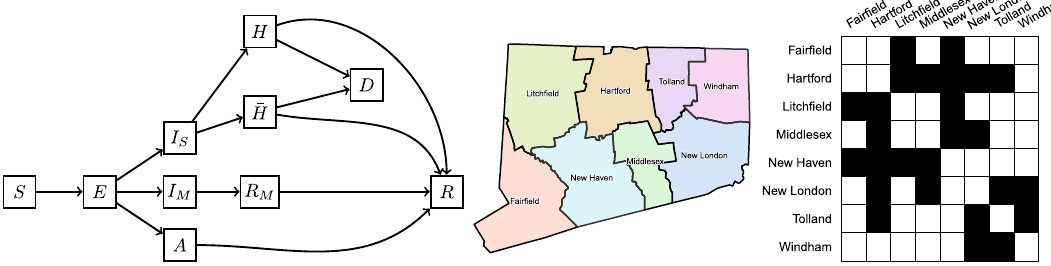
Figure 2. Schematic illustration of the model of SARS-CoV-2 transmission and COVID-19 disease progression; county map of Connecticut and county adjacency matrix. Individuals begin in the susceptible ( S ) compartment. Exposed individuals ( E ) may develop either asymptomatic ( A ), mild ( I M ), or severe ( I S ) infection. Asymptomatic and mild infections resolve without hospitalization and do not lead to death. Mild symptomatic cases self-isolate ( R M ) shortly after development of symptoms, and transition to recovery ( R ) when infectiousness ceases. All severe cases require hospitalization ( H ) unless hospitalization capacity is exhausted, ¯ H in which case they transition to representing hospital overflow, then to recovery ( R ) or death ( D ). The model captures infection transmission in non-congregate settings, and excludes cases and deaths occurring in settings like nursing homes and prisons. It assumes a closed population without births and does not capture non- COVID-19 deaths. In the adjacency matrix, the black cells correspond to counties that are